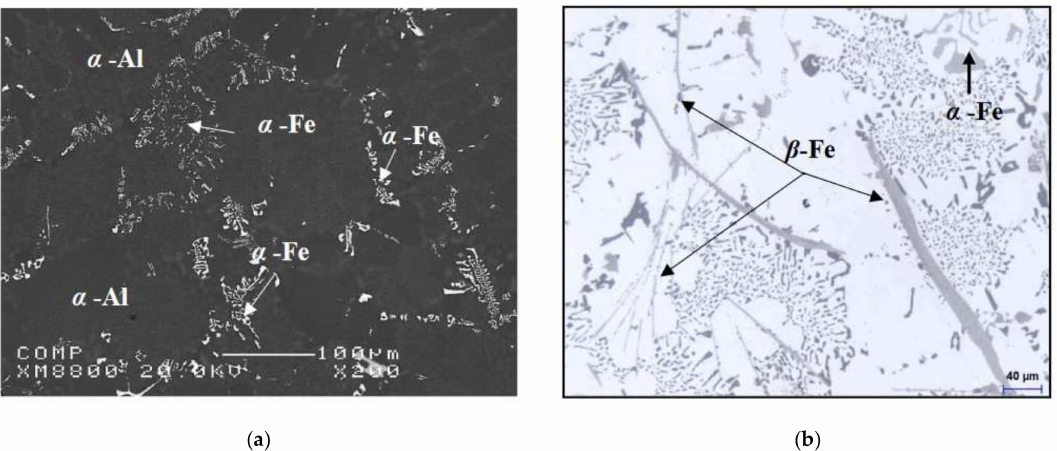
Figure 13. Backscattered and optical images showing the effects of the addition of Fe on the mi- crostructure of grain-refined and heat-treated Al-11%Si alloys. ( a ) 0.5% Fe alloy (low Fe content); ( b ) 1.0% Fe alloy (high Fe